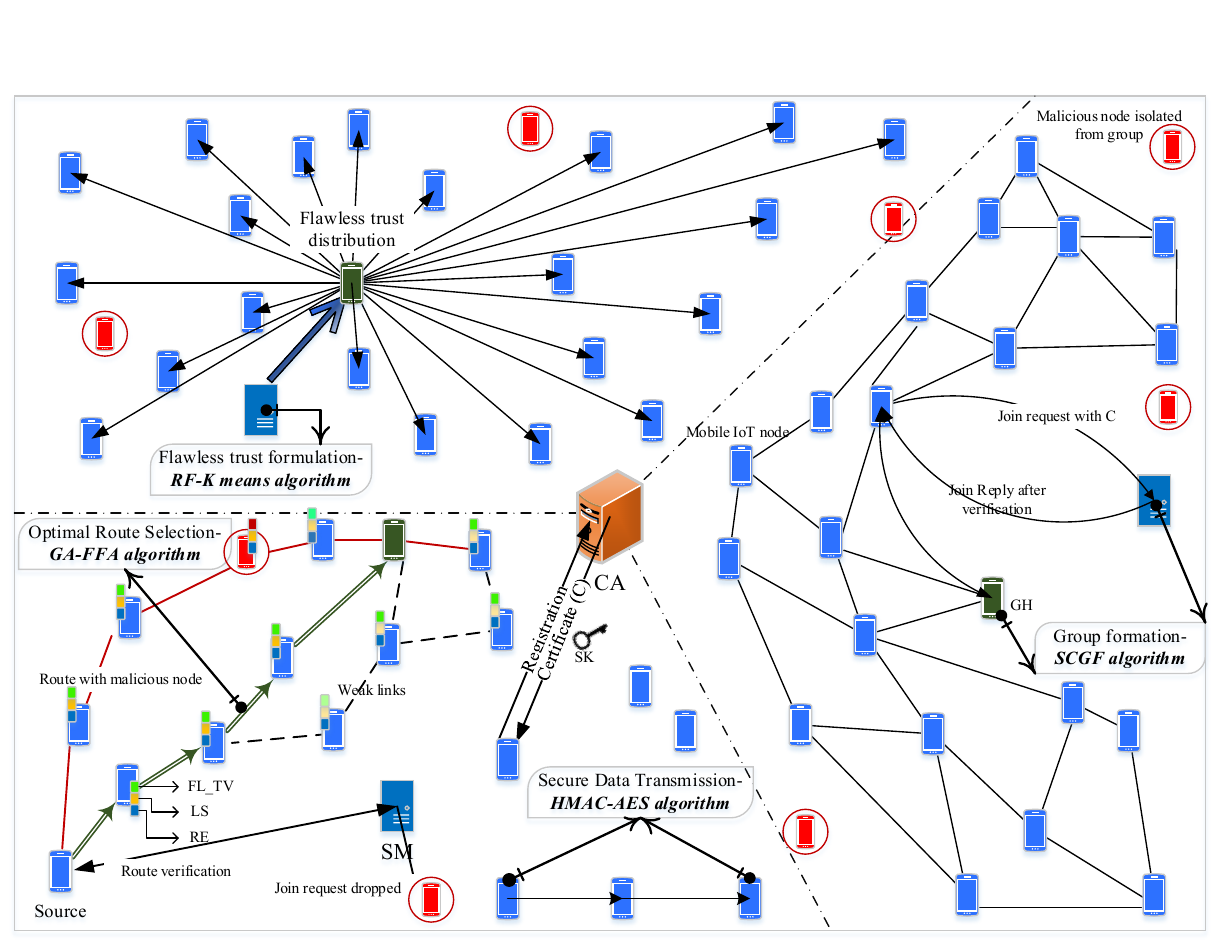
Figure 2 . Proposed Secure MANET-IoT